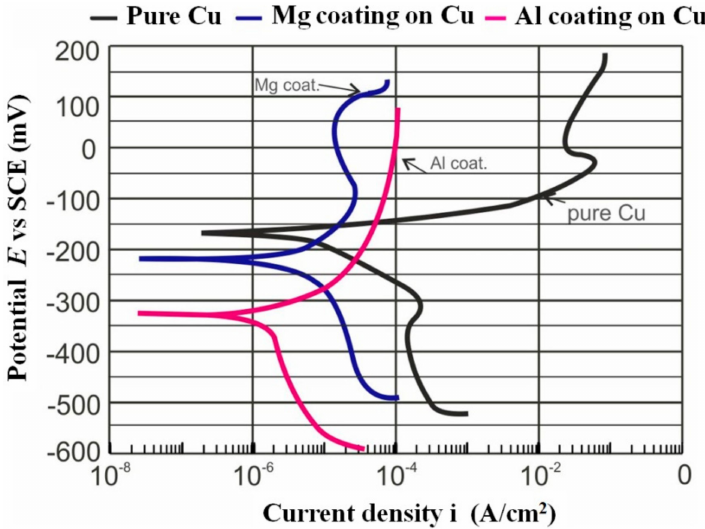
Figure 12. Potentiodynamic polarization curves of uncoated and coated samples in 3.5 wt.% NaCl solution at 25 ◦